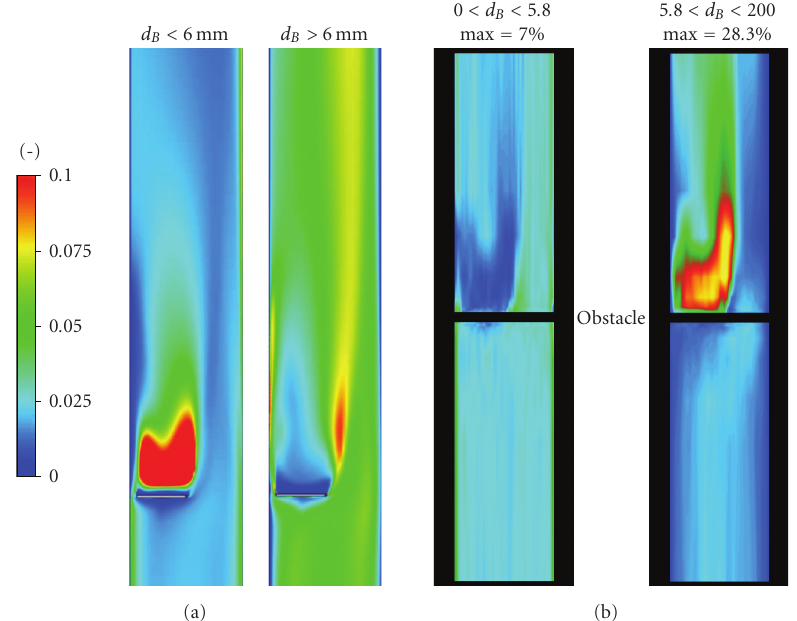
Figure 15: Calculated by CFX (left) and measured (right) gas distributions up- and downstream of the obstacle resolved to bubble size classes (run 096 J L = 1 . 017 m/s, J G = 0 . 0898 m/s, F B = 0, F C = 0 .